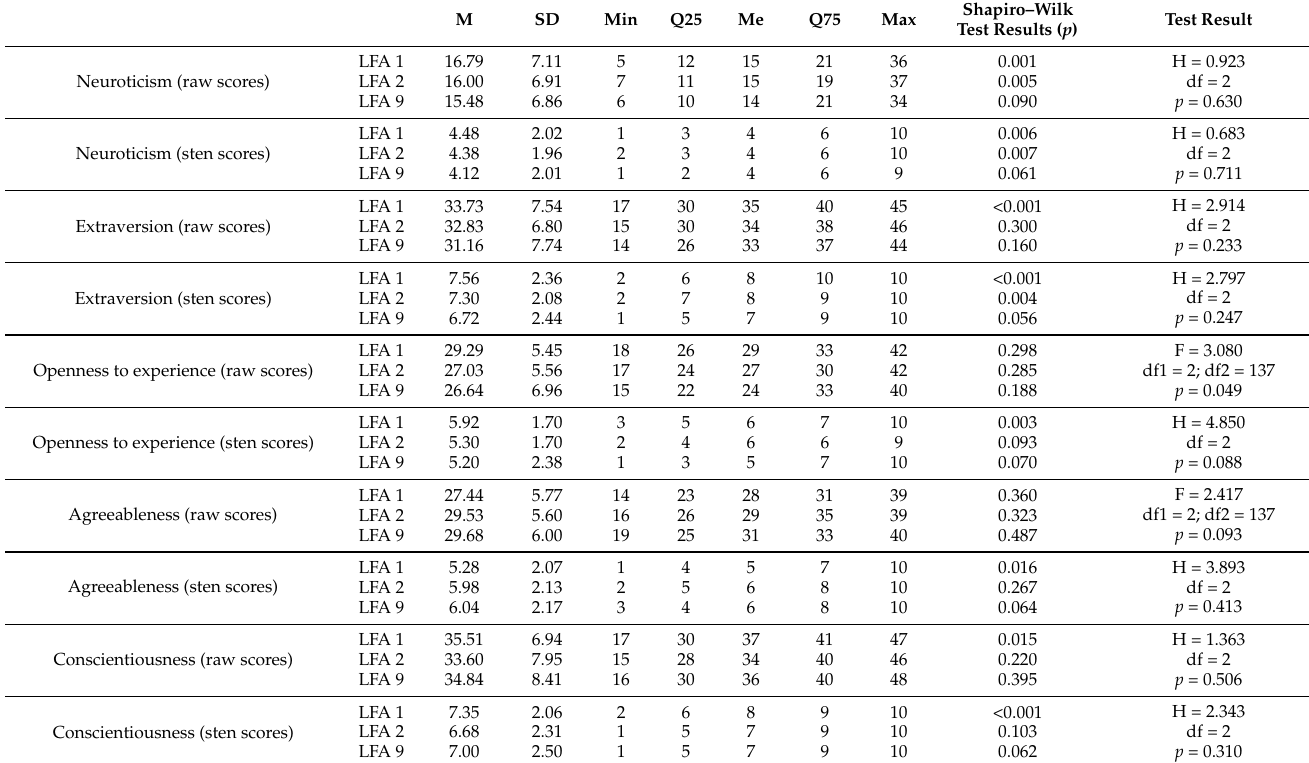
Table 2. Data on the personality profiles of American football players aged 20–29 years in Poland according to the LFA game